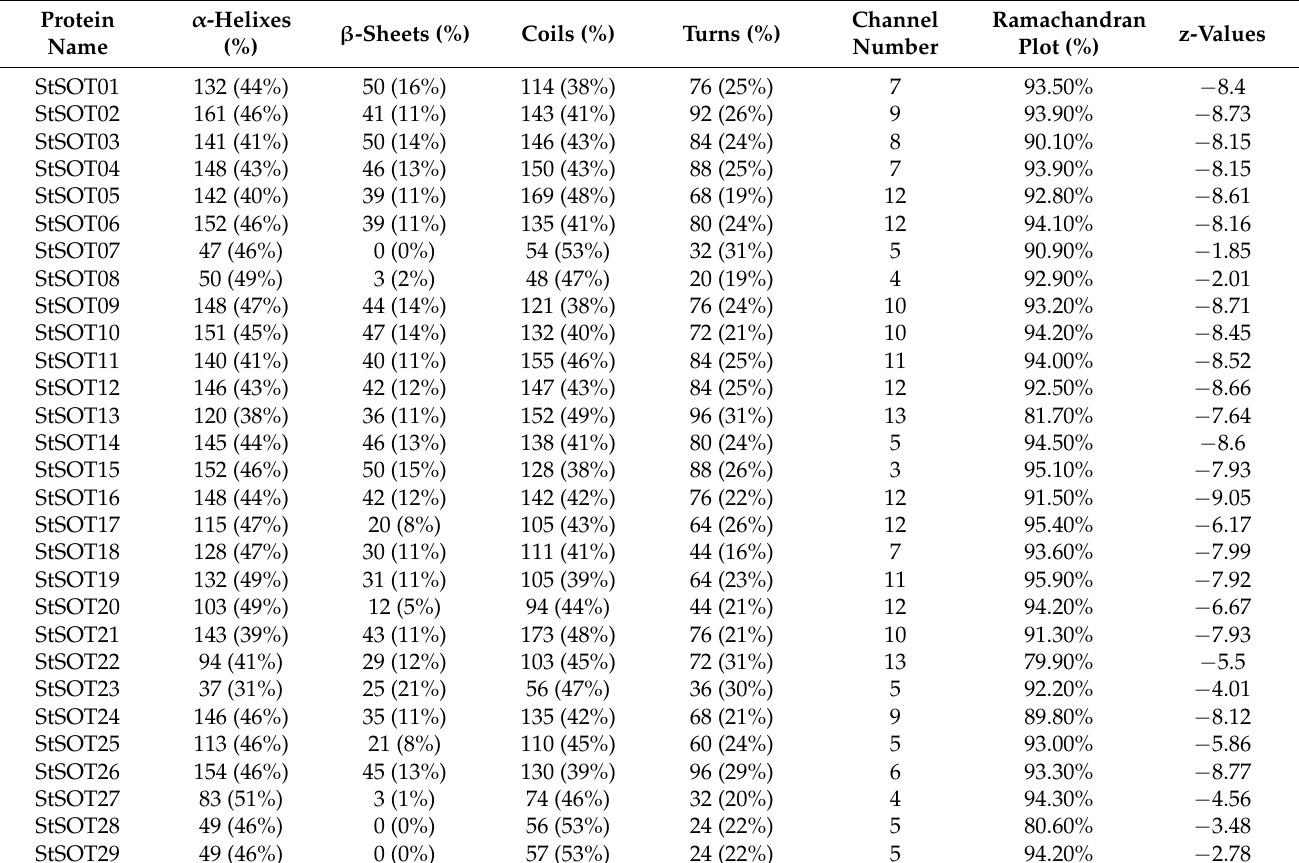
Table 4. Properties of secondary and tertiary structures of StSOT proteins, validation, and channel